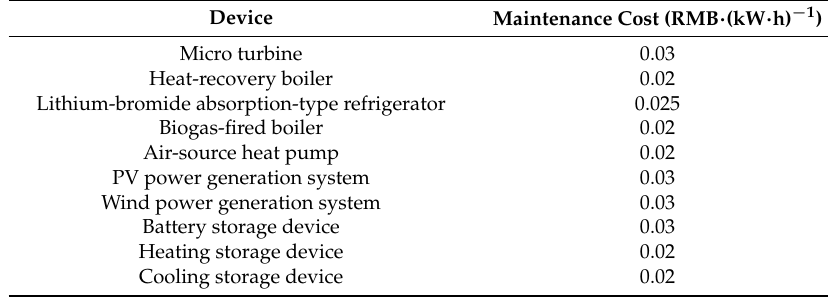
Table 2. Maintenance costs of the energy-supply device.